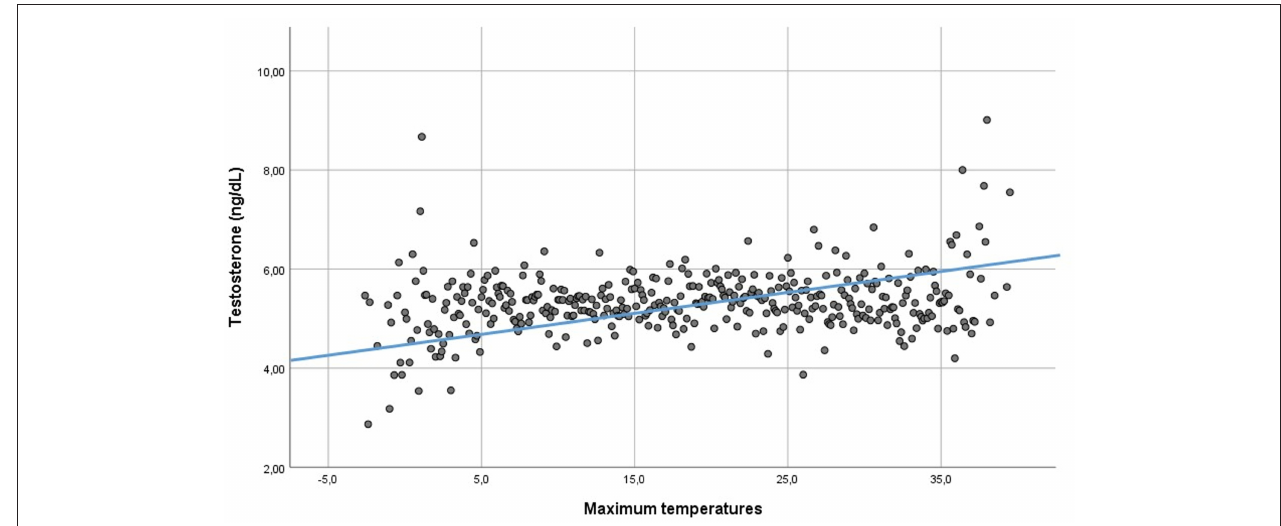
FIGURE 5 | Linear regression between testosterone serum levels and environmental maximum